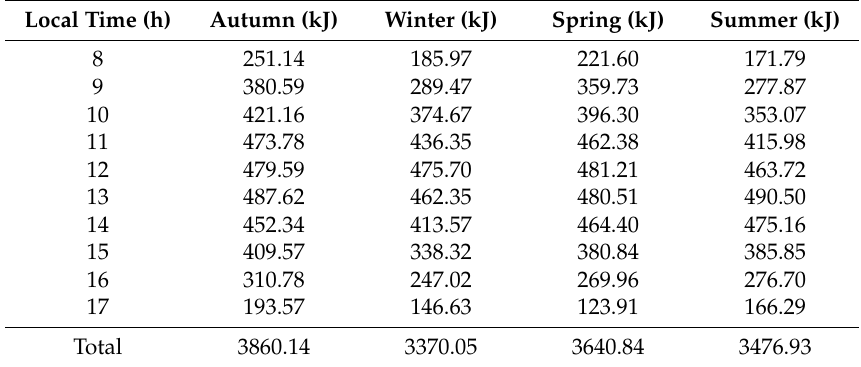
Table 5. Seasonal energy availability at receiver for multi-position setup (summer 0 ◦ , spring/autumn 16 ◦ , winter 32 ◦